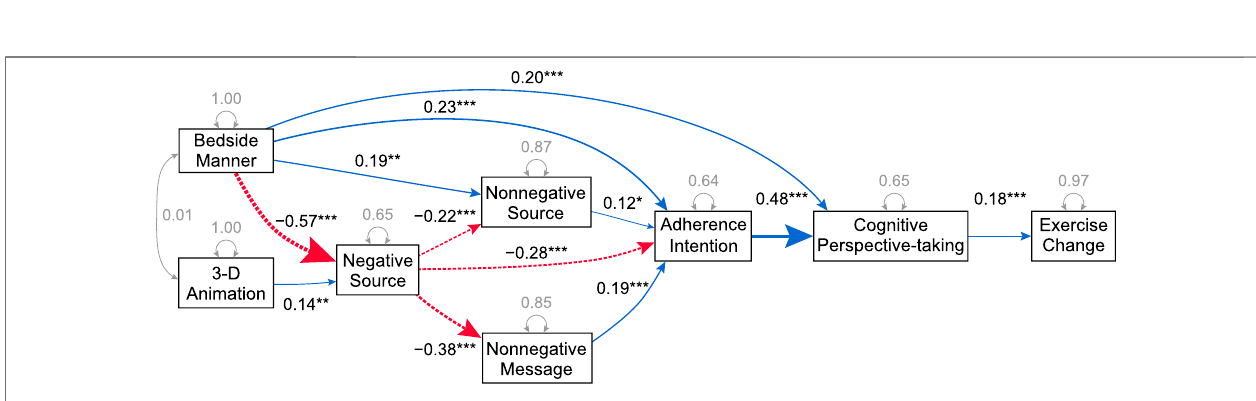
FIGURE 9 | Model 11: Path model of Exercise Change with HSM variables. The model includes the number of negative and nonnegative source-related thoughts and the number of nonnegative message-related thoughts.